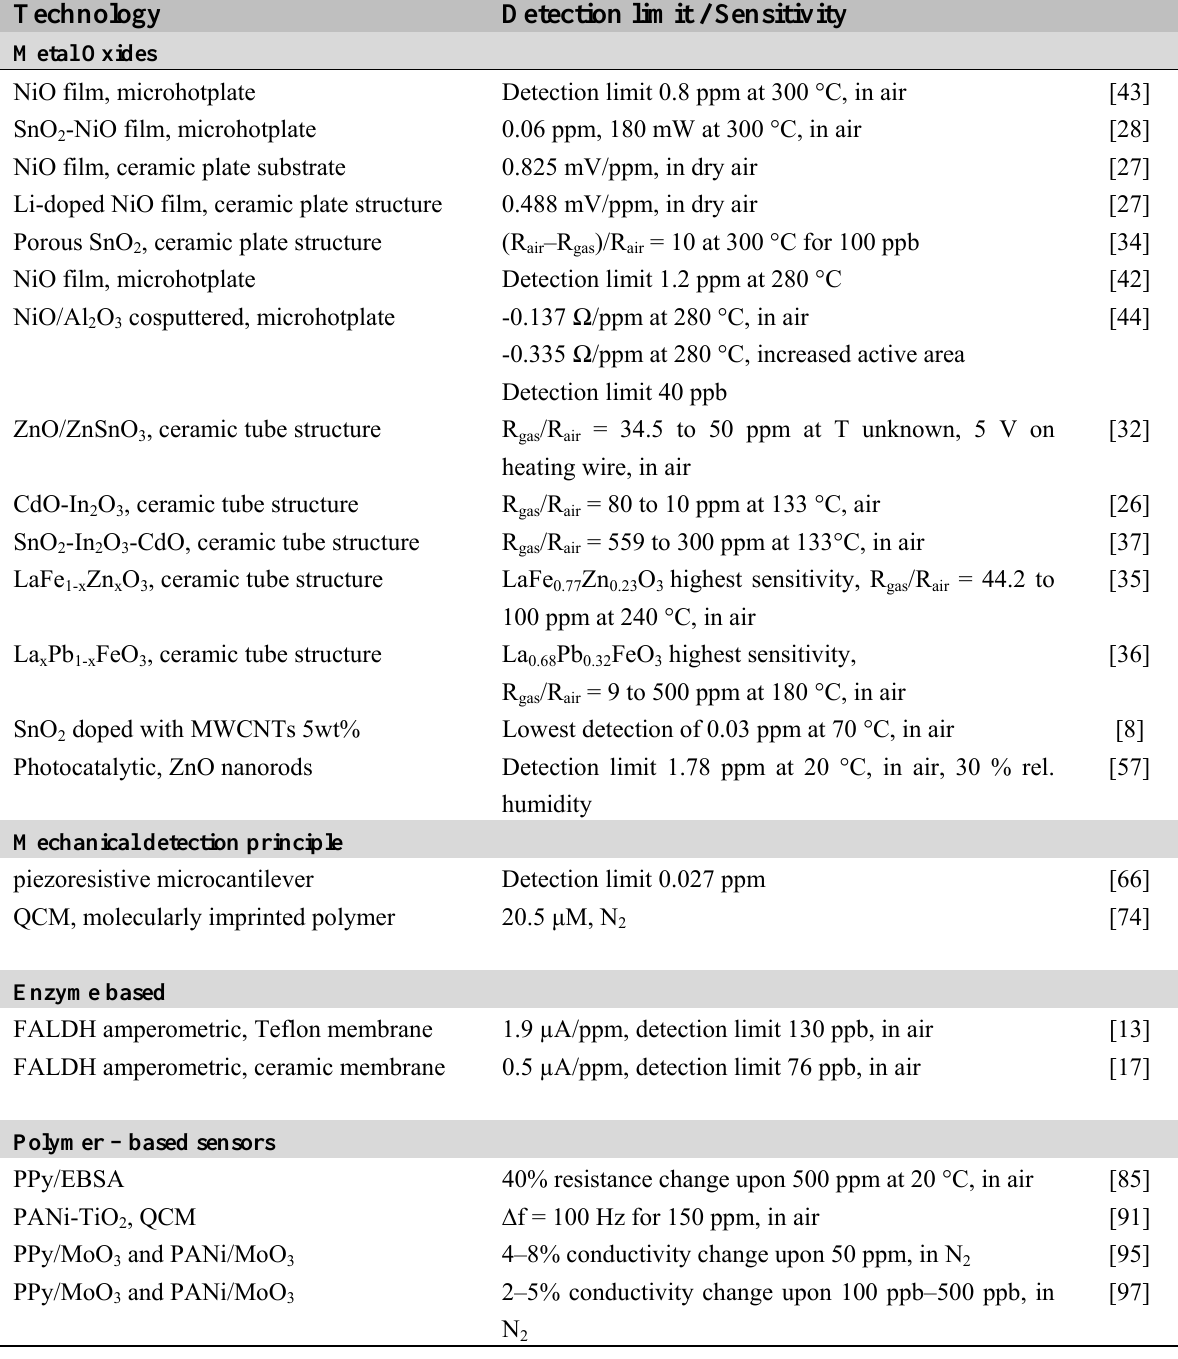
Table 1. Microfabricated formaldehyde gas